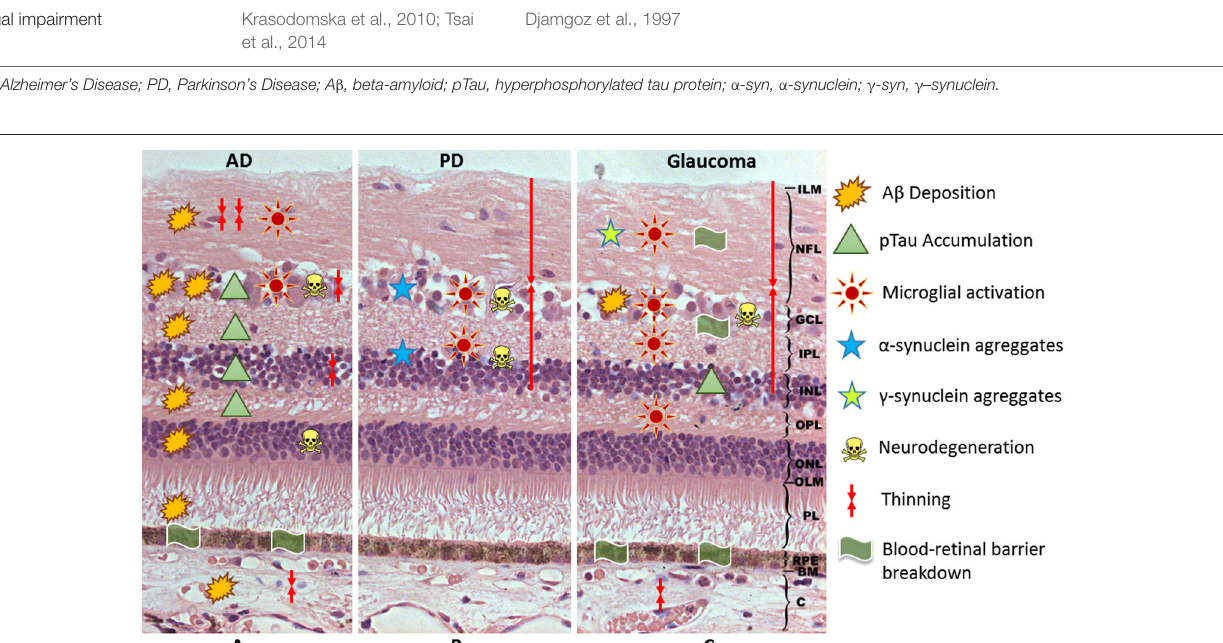
are found in midbrain dopaminergic neurons (Neystat et